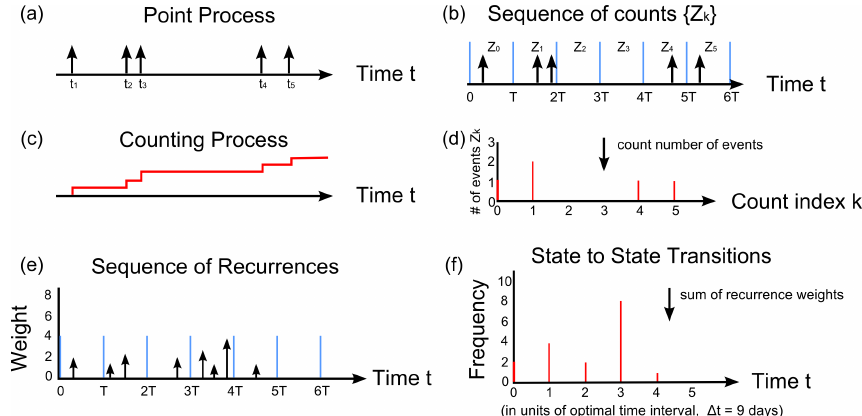
Figure 5. Representation of a point process (a–d) versus representation of a state-to-state transition ( e and f ). (Adapted from Thurner et al.,